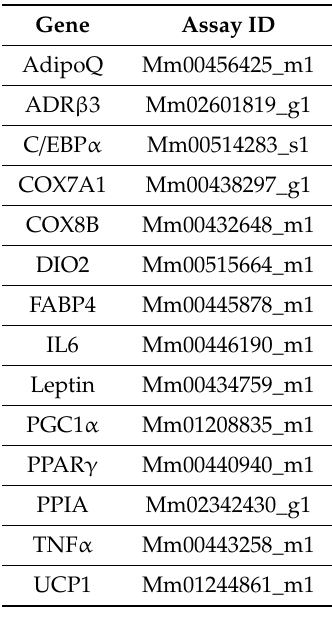
Table 1. List of TaqMan ™ Gene Expression Assays